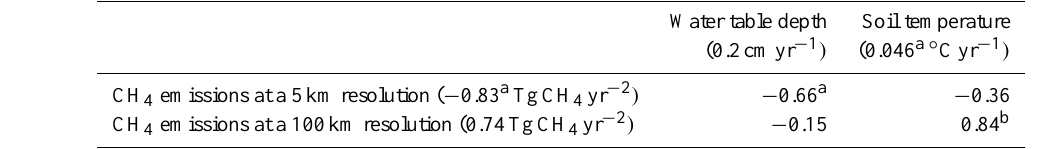
Table 1. Pearson correlations between annual CH 4 emissions (at 5km and 100km resolutions) and spatially averaged water table depth and top-layer (0–5cm) soil temperature during the growing season (May–September) over the pan-Arctic during the period 1993–2004. The annual changing rate of each variable is given in corresponding brackets. Water table depth Soil temperature